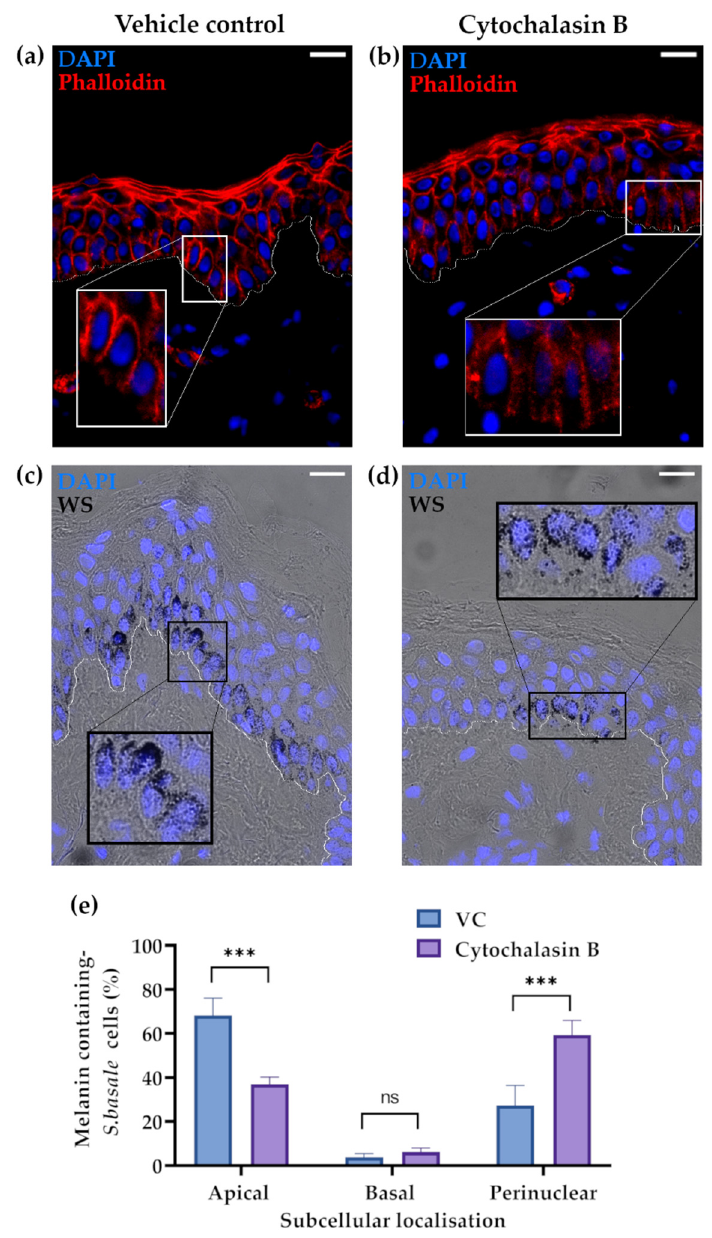
Figure 2. Reduced actin polymerisation after cytochalasin B treatment affects melanin aggregation in the S. basale KCs in human skin ex vivo. ( a ) Polymerised actin (phalloidin staining) is shown in red in VC- and ( b ) cytochalasin B-treated skin after 24 h in culture. Nuclear counterstain (DAPI) is shown in blue. ( c ) Warthin–Starry stain shows melanin localisation in VC- and ( d ) cytochalasin B-treated ex vivo skin after 24 h in culture. Scale bar = 20 µm. The basement membrane zone is shown by a white dotted line. ( e ) Quantification of subcellular localisation of melanin. Graph shows the percentage (%) of S. basale cells with apical, perinuclear, and basal located melanin. Data are the mean ± SD of three independent biological experiments ( n = 3 donors; 61–131 cells/replicate). *** indicates p -value < 0.001 and ns indicates not significant in a two-way ANOVA test.